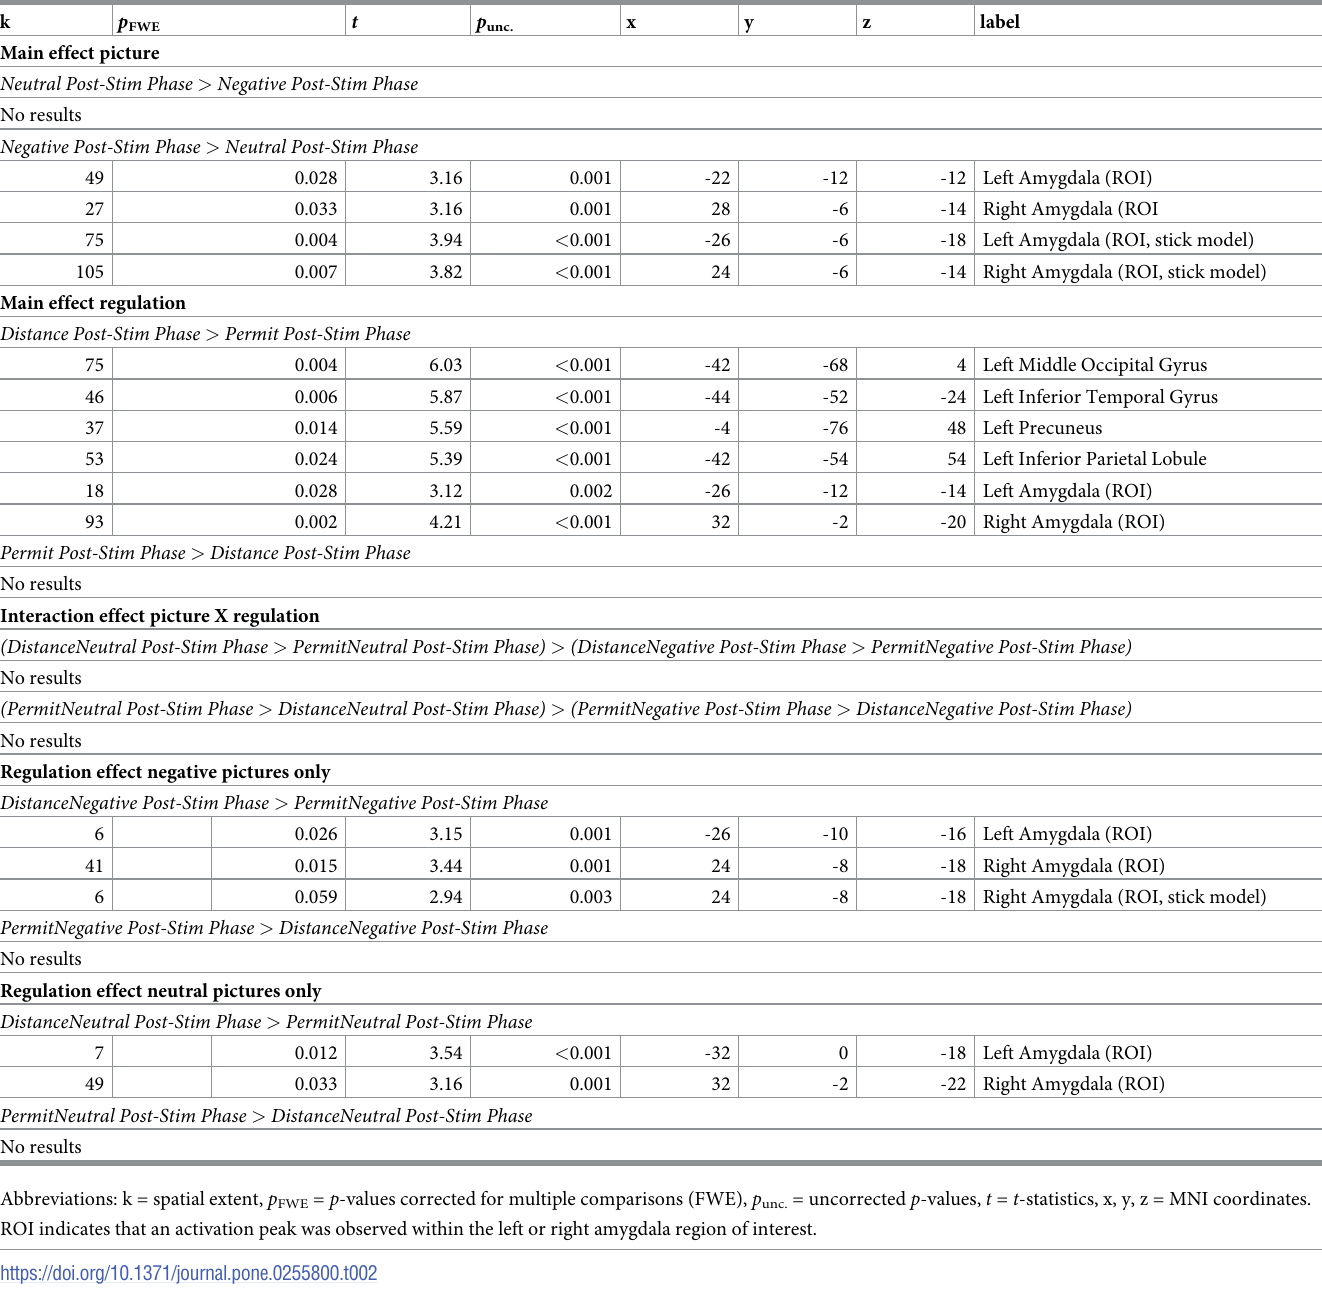
Re-exposure after 1 week (long-term effects, timepoint 4). Re-exposure after 1 week led to greater activation for negative than for neutral pictures in several brain regions, including the right inferior temporal gyrus, left occipital, fusiform, and inferior frontal gyrus, and the left and right amygdala (Table 5). Again, there was an effect of the previous regulation condition: greater activation for previously distanced pictures was present in the right amygdala (Fig 5). Restricting this comparison to negative pictures did not yield any significant effect, but a small